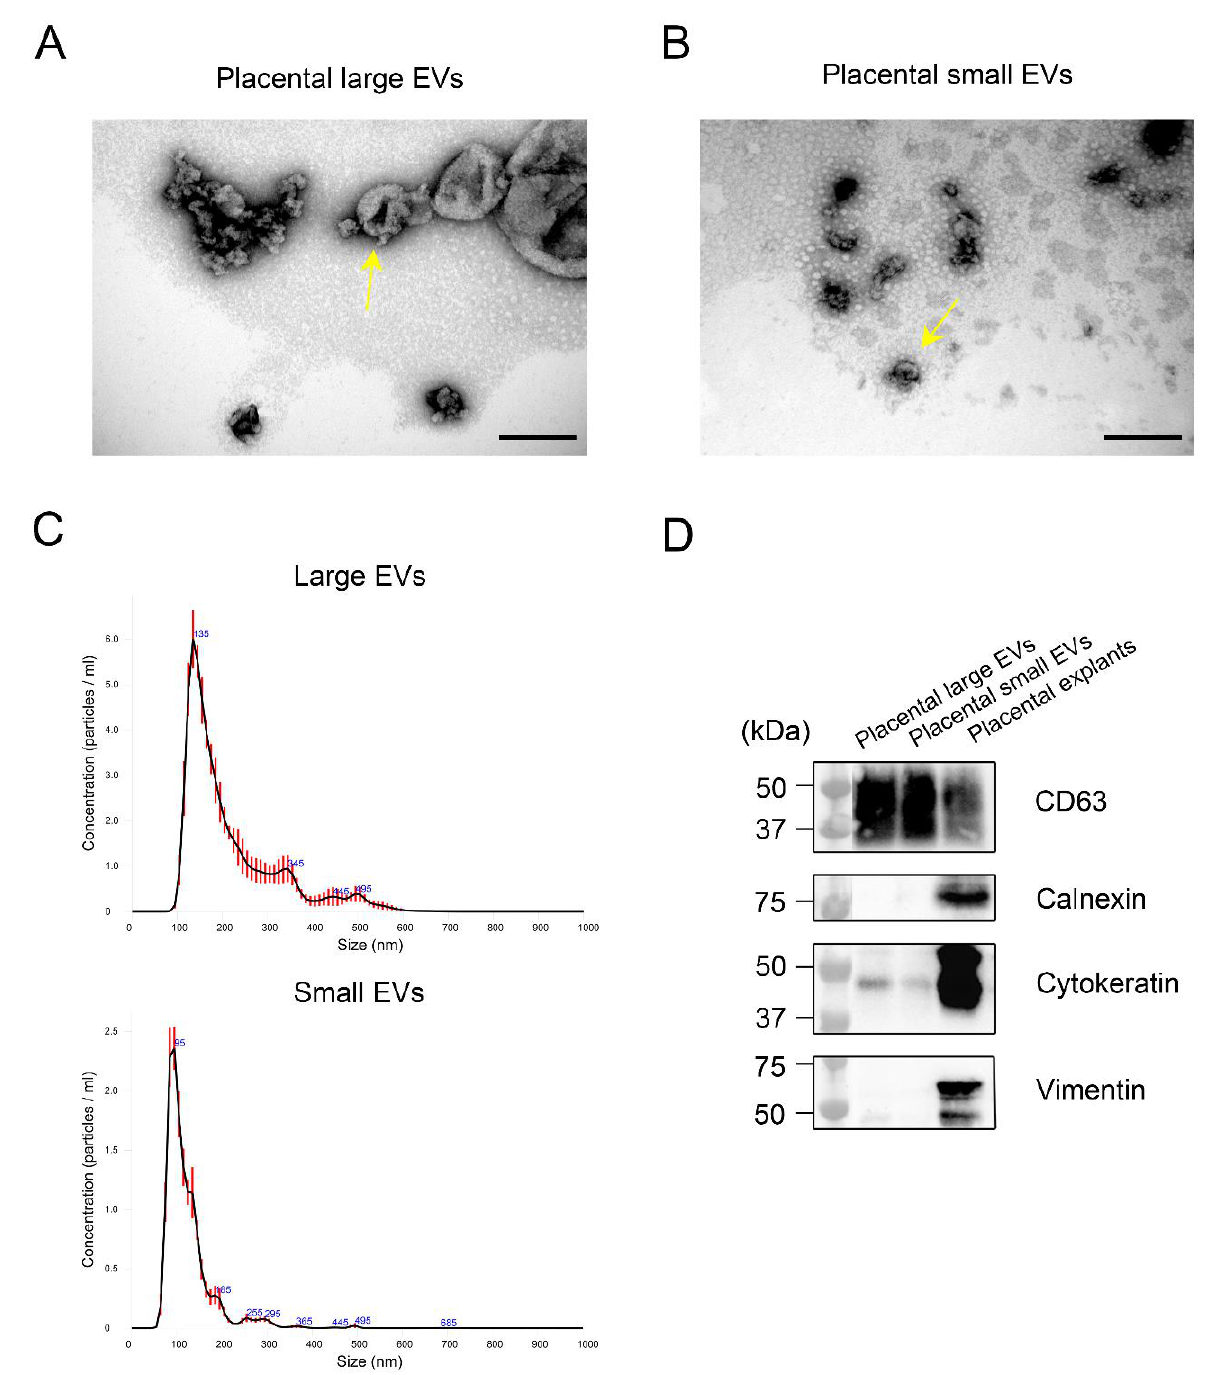
Figure 1. Characterization of the large- and small-extracellular vesicles (EVs) derived from the human term placentae. Representative electron micrograph of the characteristic morphology of the isolated large EVs with diameters of approximately 170nm (yellow arrow) ( A ) and small EVs with diameters of approximately 60nm (yellow arrow) ( B ), Scale bar = 200 nm. Nanoparticle tracking analysis of the size distribution in the large and small EVs, using the NanoSight NS300 system ( C ), error bars indicate ± 1 standard error of the mean ( n = 3 in each group). Representative western blots of specific markers present in the large and small EVs, derived from human placentae: CD63, Calnexin, Cytokeratin and Vimentin ( D ). A lysate of the placental explants served as a control.